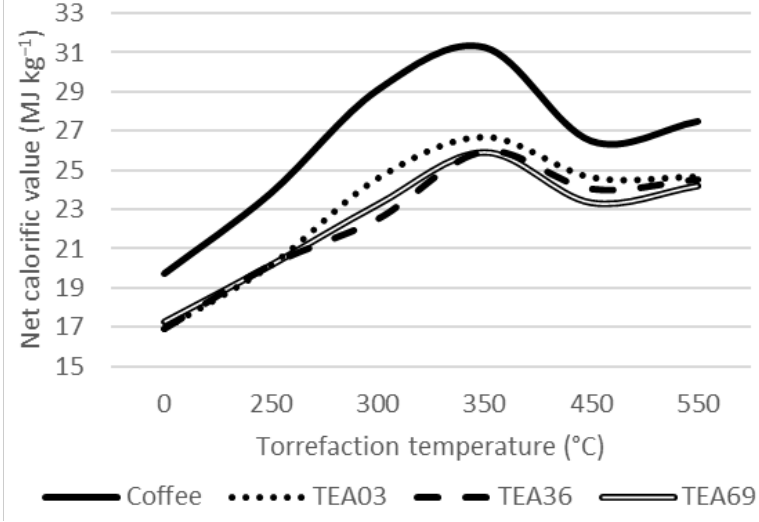
Figure 3. Net calorific value of the material.